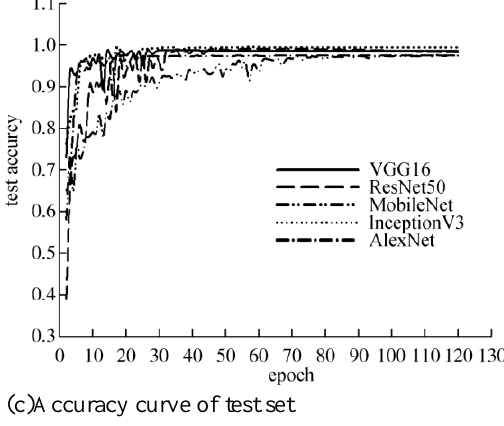
(c)Accuracy curve of test set